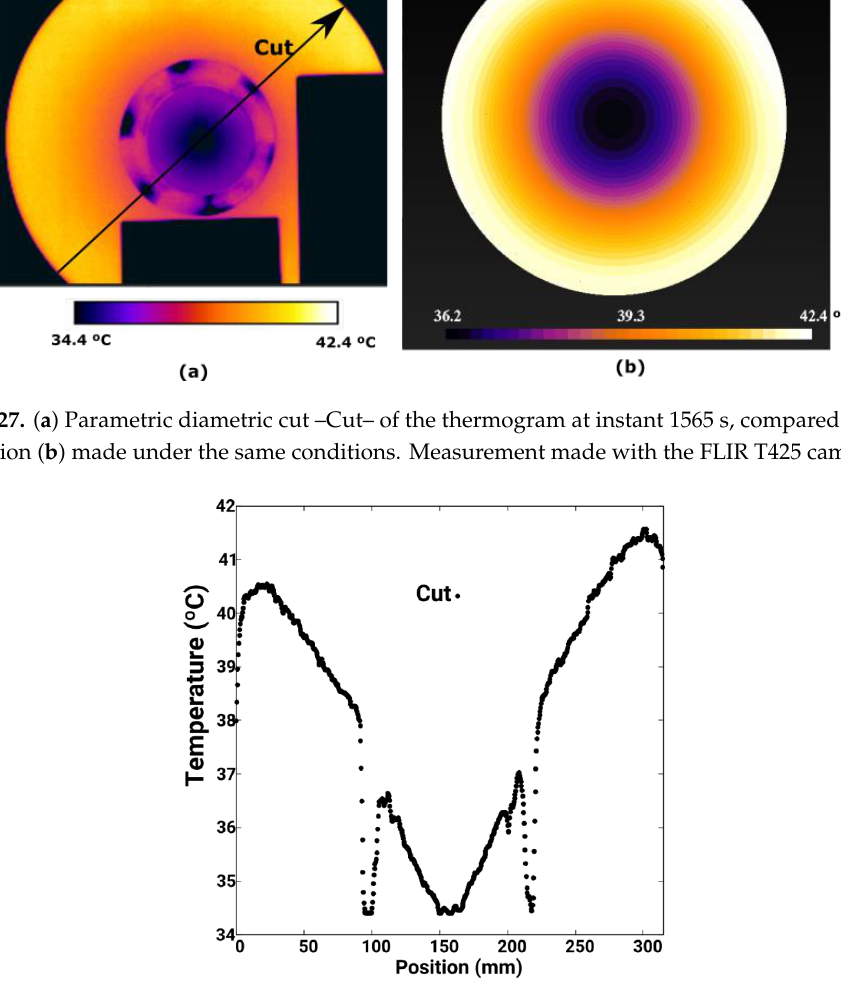
Figure 28. Temperature distribution of the parametric cut of Figure 27a, at instant 1565 s. The thermographic data has been obtained with the Fiji image analyser.